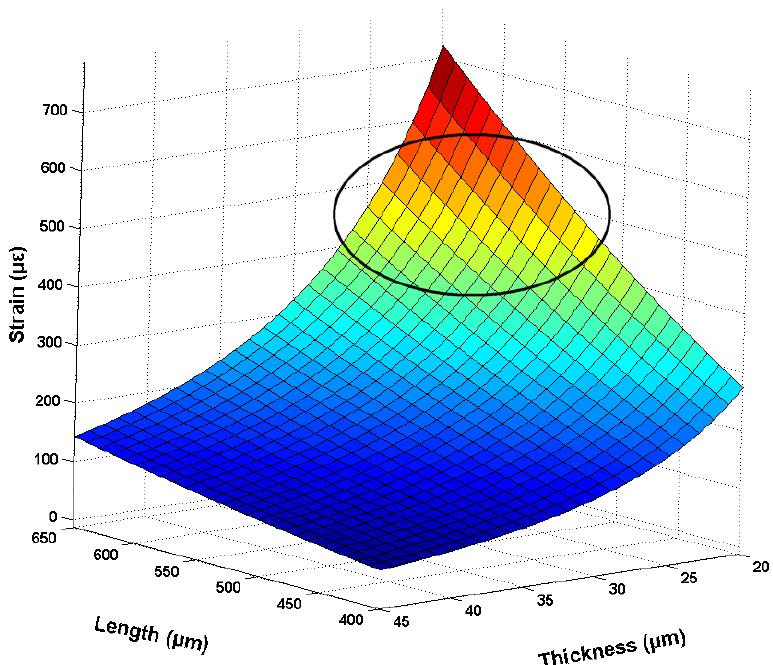
Figure 2. Calculated strain versus the diagram size and thickness.